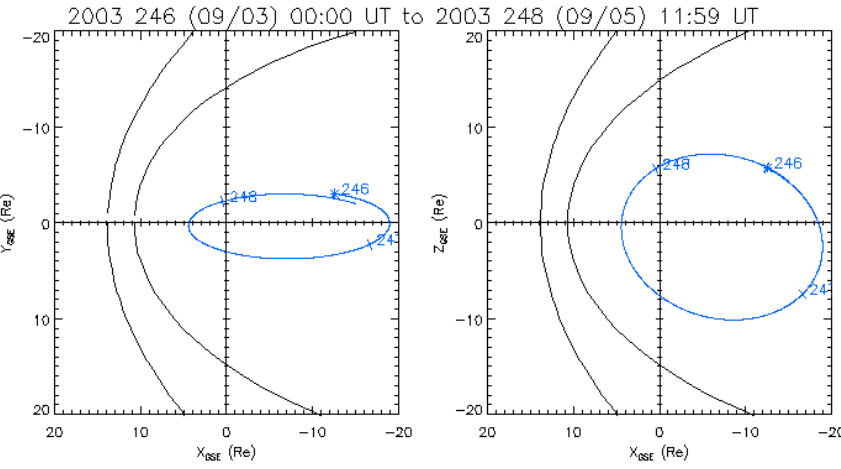
Fig. 1. Example of Cluster orbit (here in September 2003) leading to crossings of the cusp at middle altitude. Also shown are the magne- topause and the bow